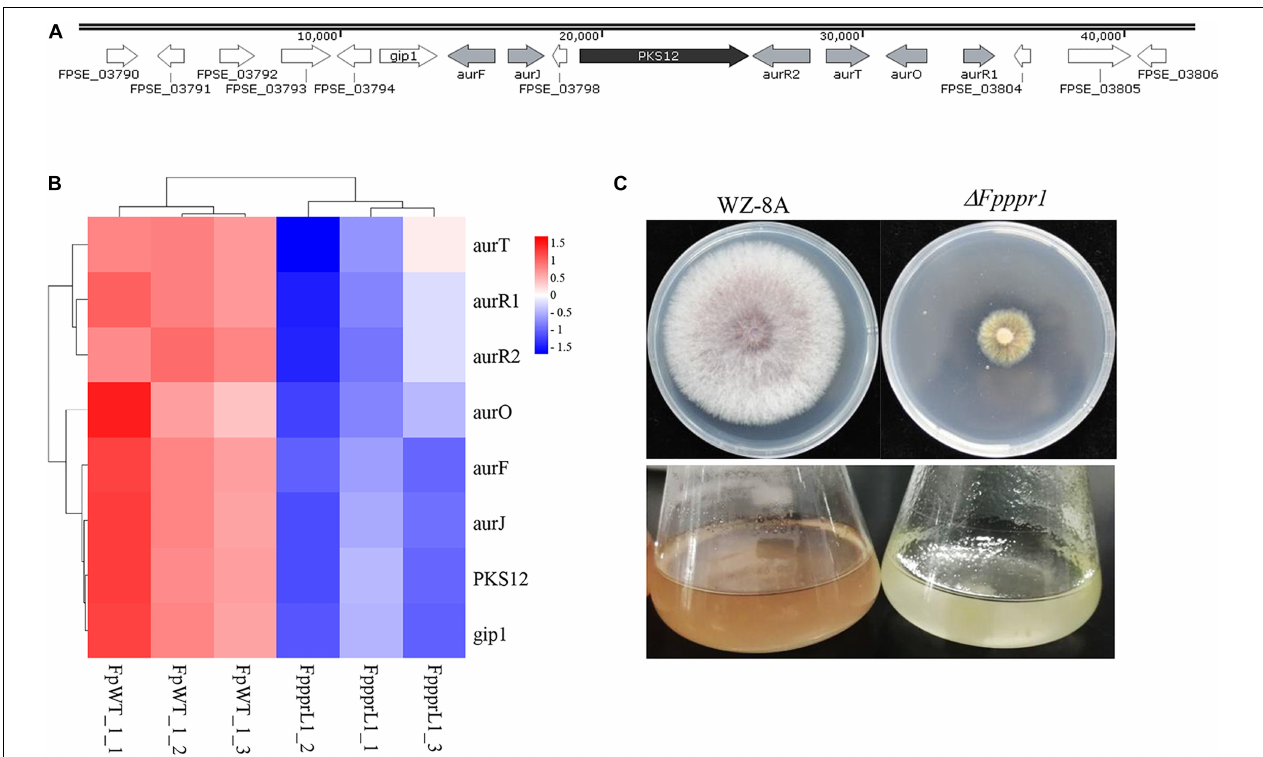
FIGURE 9 | The PKS12 cluster is responsible for aurofusarin biosynthesis. (A) Retrieved genomic sequences and mapping of the PKS12 cluster. The arrows indicate ORFs and transcriptional directions, AUR genes are gray, PKS12 is black, and other genes are white. (B) Heatmap of the PKS12 cluster with reduced expression levels in (cid:49) Fpppr1 mutant from RNA-seq data. (C) The comparison of pigmentation from wild type WZ-8A and the (cid:49) Fpppr1 mutant on PDA plates and CMC liquid